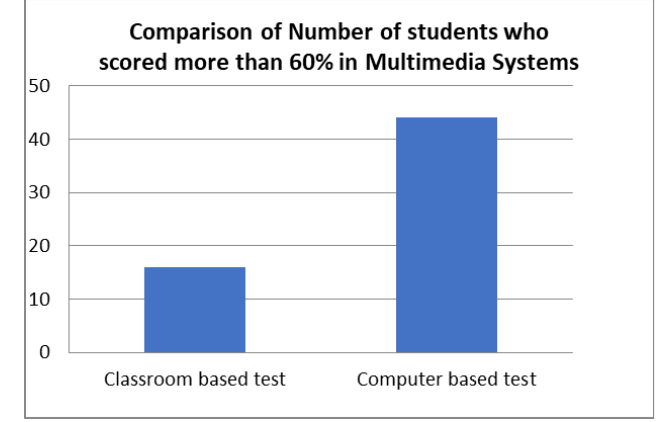
Fig. 2. Comparison of no. of students who scored more than 60%